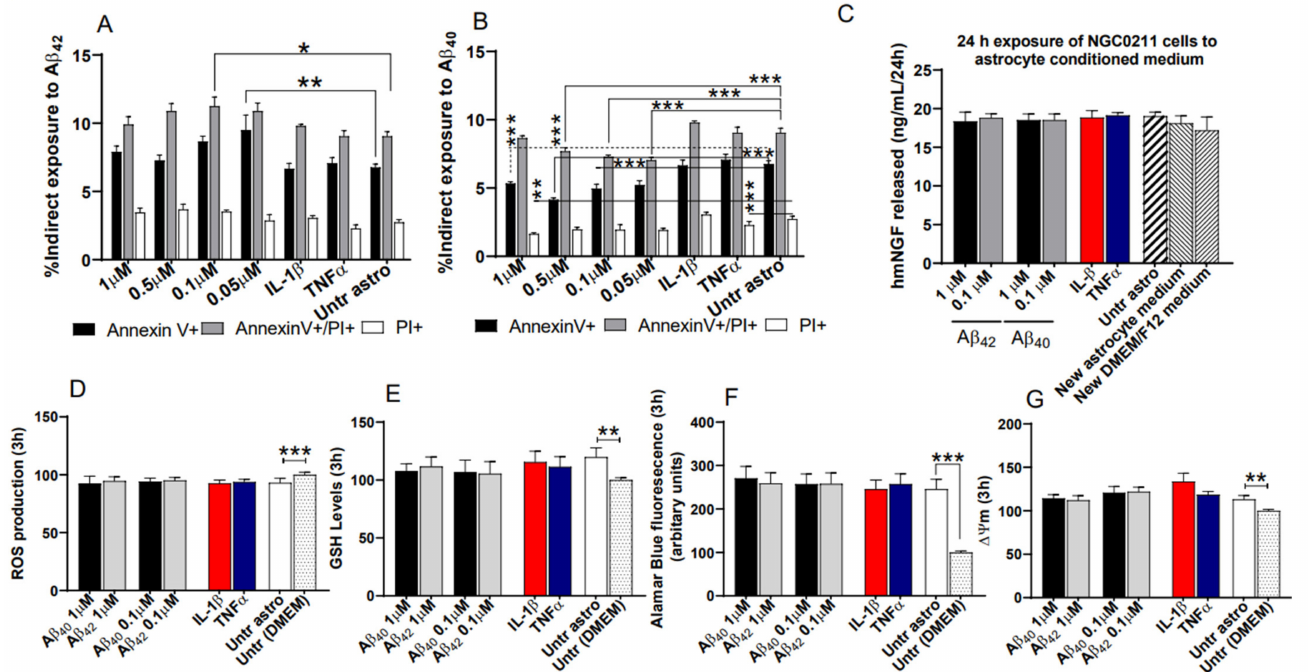
Figure 4. Activated astrocyte-conditioned medium (ACM) modulates NGC0211 cell survival, hmNGF release, and stress pathways. Astrocytes (7 × 10 4 cells/well) were cultured in 24-well plates and challenged with A β 40/42 peptides (1, 0.5,